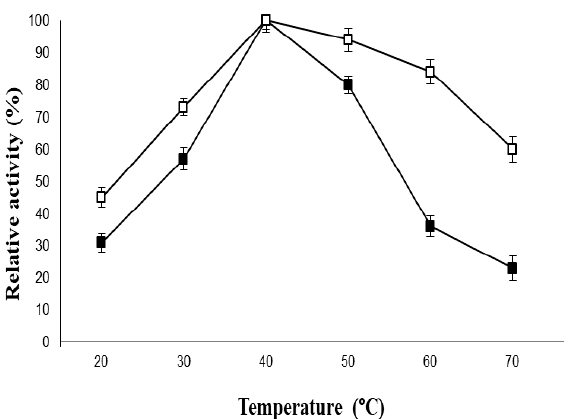
Figure 6. Temperature activity profiles of soluble and immobilized β -galactosidase. For symbols, please refer to the legend of Figure 5.